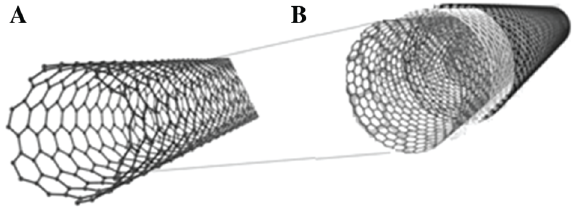
Figure 3: Structures of CNTs. (A) SWCNT; (B)